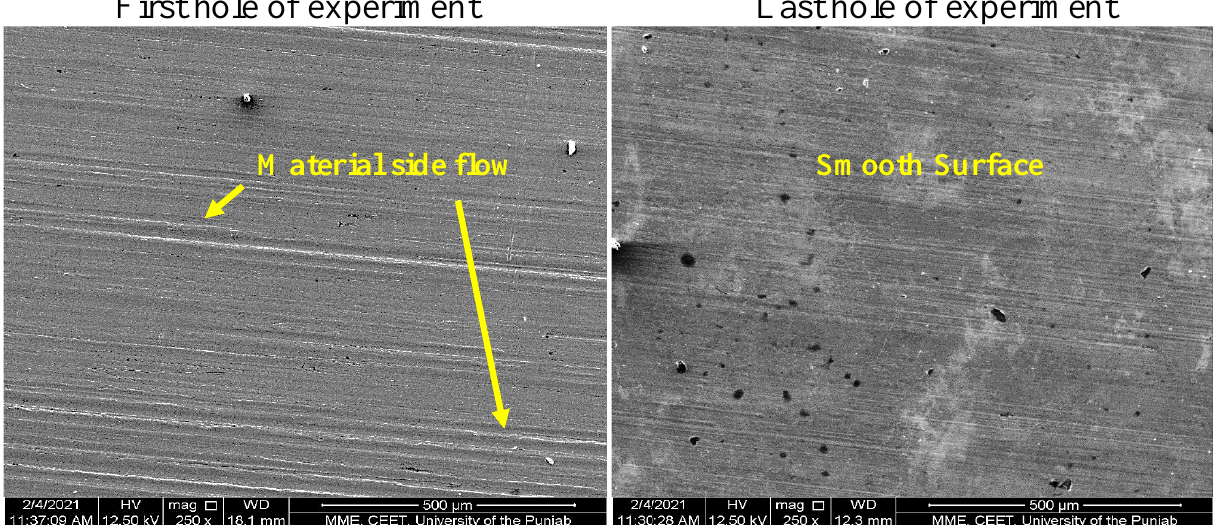
Figure 19. Surface topography of cross-sectional SEM images of drilled holes of Tests 1 (25 m/min, 0.04 mm/rev).